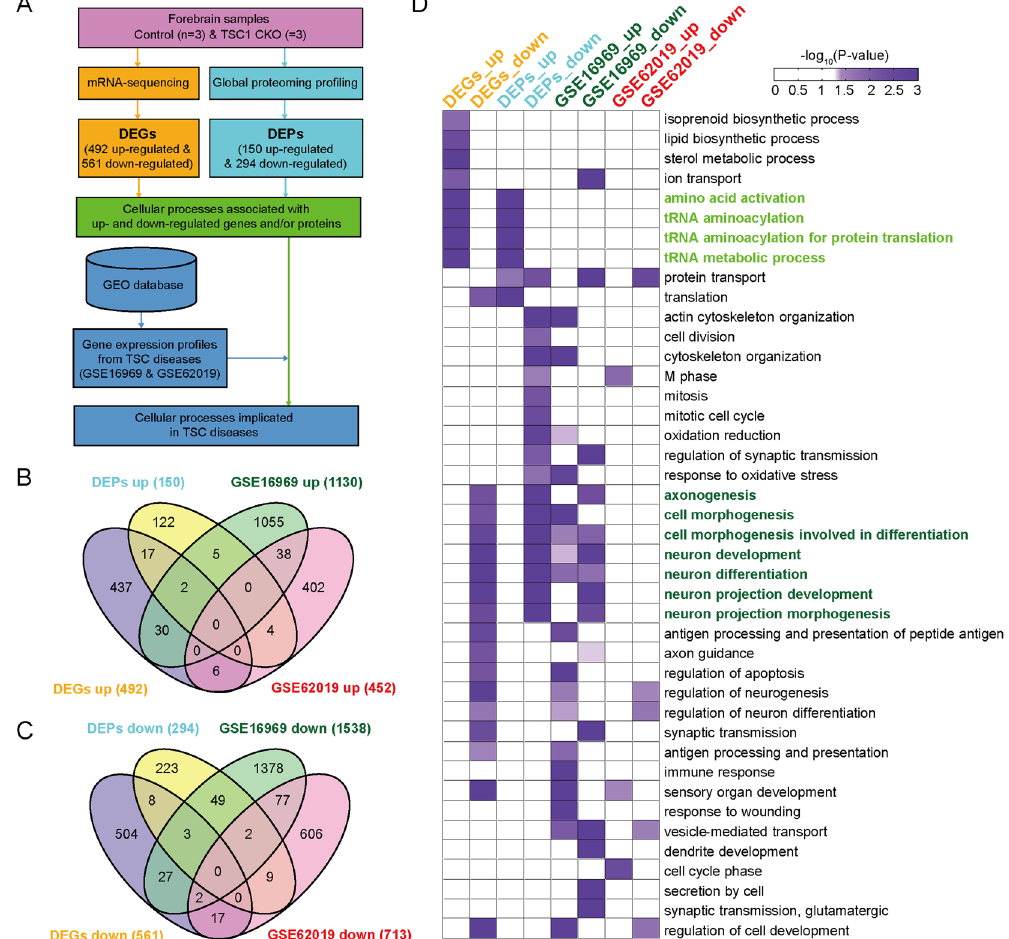
Figure 3. TSC-implicated cellular processes affected by hyperactivated mTOR signaling. ( A ) The overall scheme of integrative analysis of DEGs and DEPs by hyperactivated mTOR signaling and DEGs identified from transcriptomic data of TSC patients (GSE16969 and GSE62019). GOBPs represented by DEGs and DEPs by hyperactivated mTOR signaling and DEGs identified from TSC transcriptomic data were integrated. ( B , C ) Relationships among DEGs and DEPs by hyperactivated mTOR signaling and DEGs identified from GSE16969 and GSE62019. Venn diagrams were separately made for up- ( B ) and down-regulated ( C ) genes or proteins. D , GOBPs represented by the following eight sets of genes and proteins: 1–4) up- (DEGs_up and DEPs_up) and down-regulated (DEGs_down and DEPs_down) genes and proteins by hyperactivated mTOR signaling and 5–8) up- (GSE16969_up and GSE62019_up) and down-regulated (GSE16969_down and GSE62019_down) genes in the two transcriptomic datasets. The significance of GOBPs being enriched by the indicated sets of genes or proteins was displayed by –log 10 ( P ) where P is the enrichment P-value obtained from DAVID software. The color bar denotes gradients of –log 10 ( P